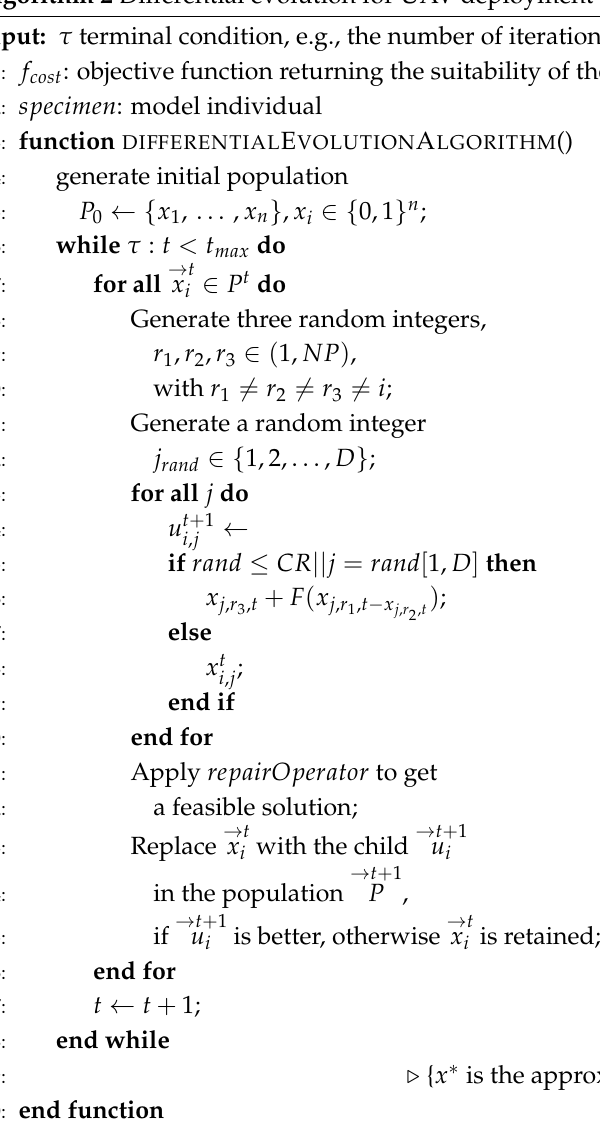
Algorithm 2 Differential evolution for UAV deployment